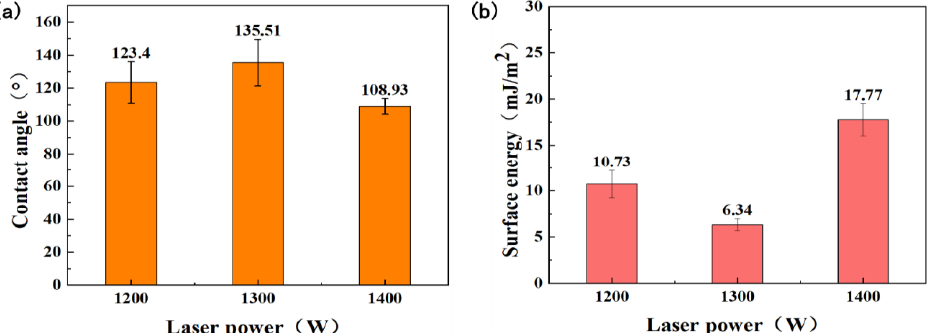
Figure 13. Measured ( a ) contact angle and ( b ) surface energy of LCC specimens No. 5–7 with Ni60/TC4 mass ratio of 3/7 and laser scanning speed of 1300 mm/min.